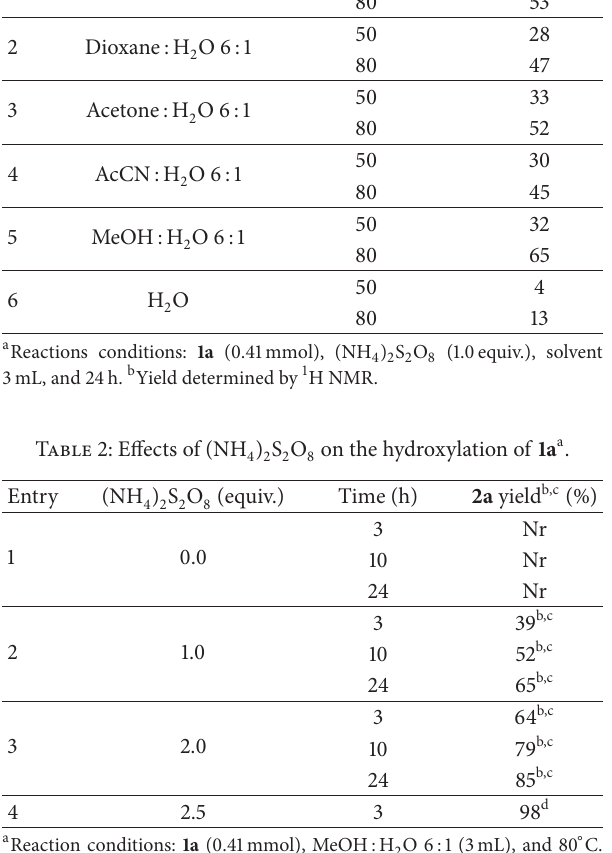
Table 1: Effects of the solvent and temperature on the hydroxylation of 1 a a .